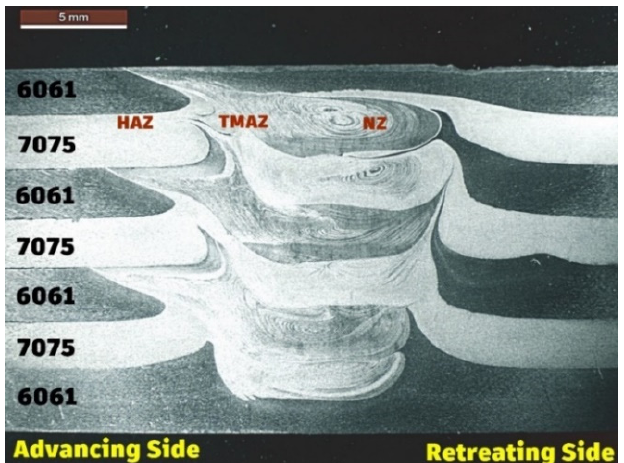
Figure 4. Cross-sectioned view of the FSAM build .